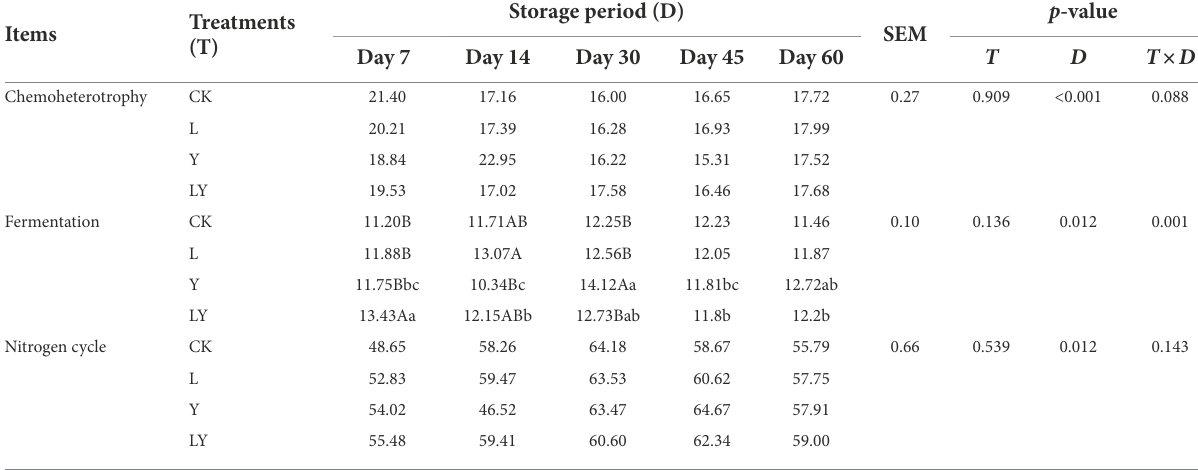
TABLE 6 Chemoheterotrophy and fermentation changes in functional prediction of bacteria in cellulase-treated Pennisetum sinese (CTPS) during anaerobic storage.